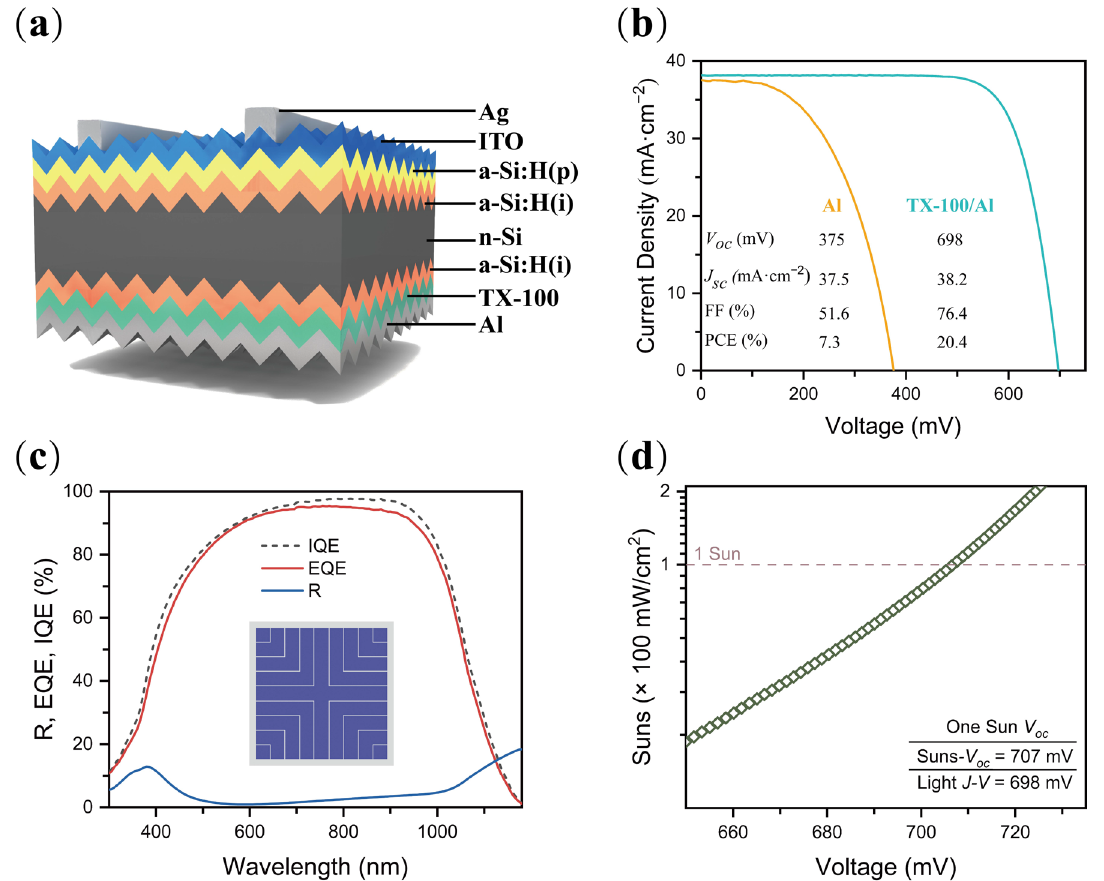
Figure 6. ( a ) Schematic of an n-type silicon solar cell with full-area a-Si:H(i)/TX-100/Al contact on the backside; ( b ) illuminated J−V curves of heterojunction solar cells without and with TX-100; ( c ) the reflectance and external/internal quantum efficiencies and ( d ) V oc of the solar cell with TX-100.